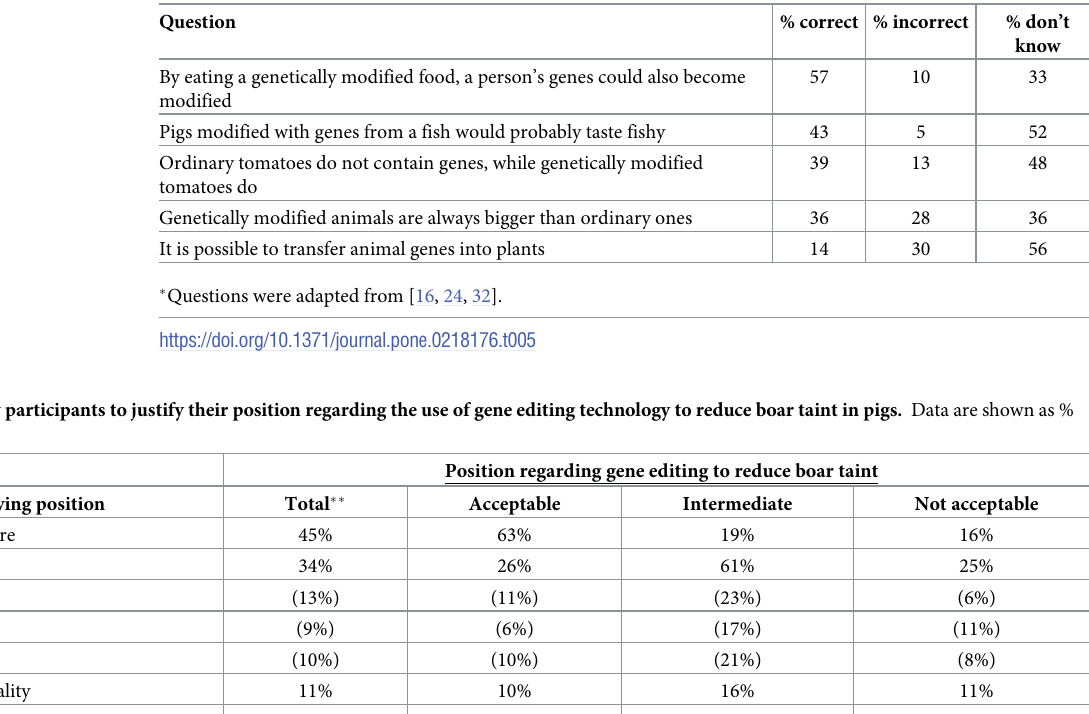
Table 5. Percentage of correct, incorrect and do not know answers of southern Brazil residents (n = 570) on the biotechnology knowledge quiz � .